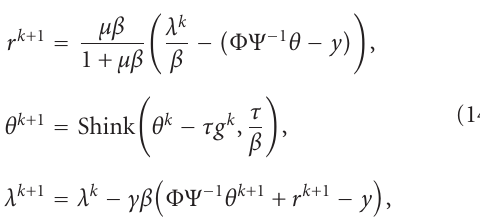
For r = r k +1 and λ = λ k are fixed, the minimization of (9) with respect to θ is equivalent